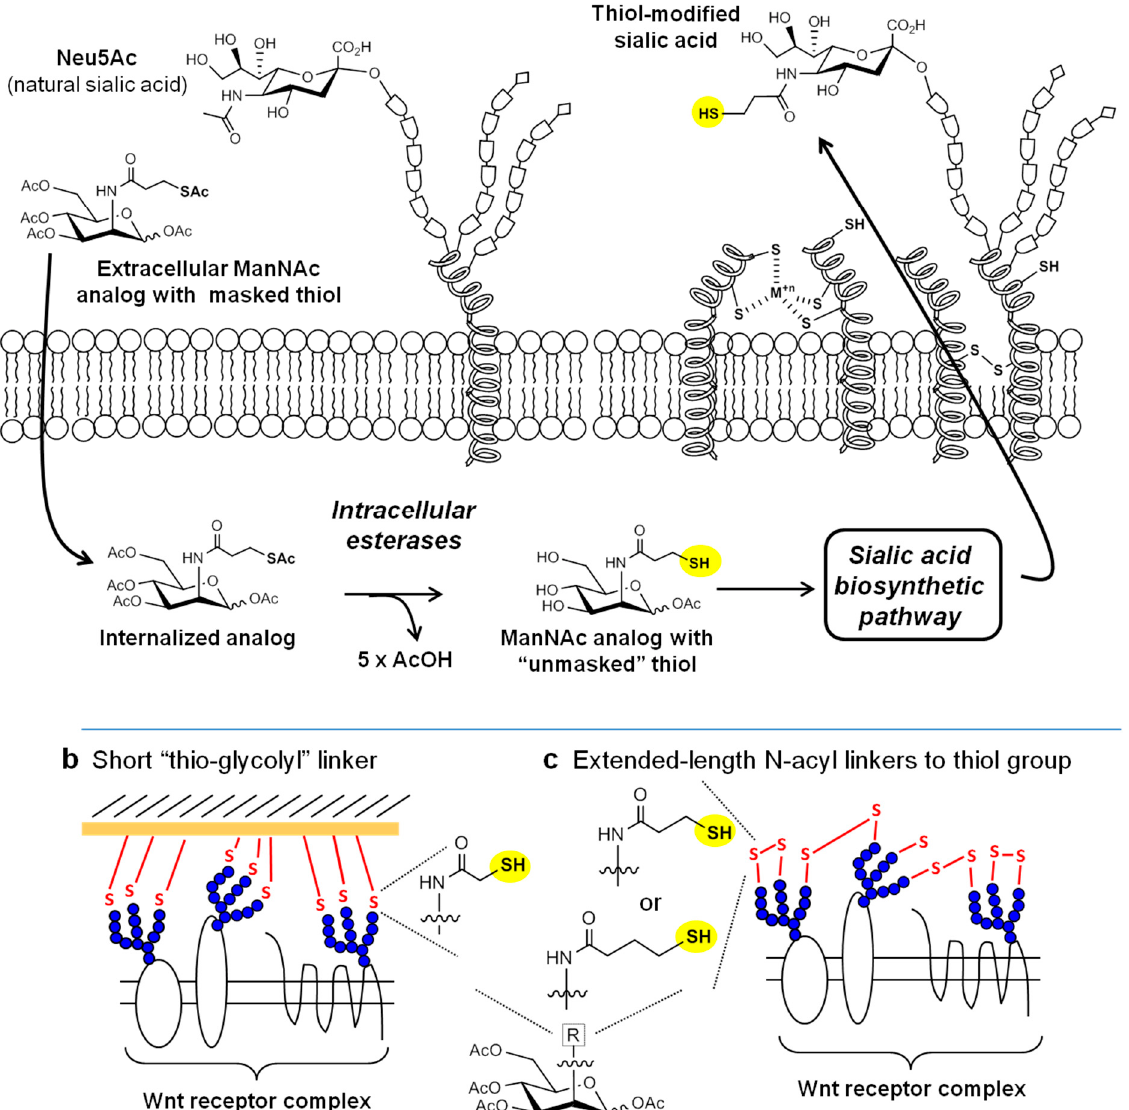
Figure 1. Overview of thiol-based metabolic glycoengineering (MGE). ( a ) Thiol groups can be metabolically installed into cell surface sialic acids by incubating cells with exogenously-supplied ManNAc analogs that have thiol groups masked by acetyl esters [5,8]; these protecting groups facilitate uptake into cells and then are removed (along with the analog’s hydroxyl esters [9,10]) by intracellular esterases [11,12]. The resulting thiol-modified ManNAc analogs intercept the sialic acid biosynthetic pathway and replace naturally-occurring sialic acids (e.g., Neu5Ac, the predominant form of this sugar in humans) in cell surface glycans with their thio-glycosialoside counterparts. ( b ) In previous work, we described the “scaffold-dependent” activity of thiol-modified sialic acids with short linker lengths between the thiol group and core sugar; an example of a ManNAc analog that installs such a sialic acid into cellular glycans is Ac 5 ManNTGc [5] (Figure 2). ( c ) In the current report, we describe thiol-modified analogs (e.g., Ac 5 ManNTProp and Ac 5 ManNTBut, also shown in Figure 2) with longer linkers (i.e., with 3 or 4 carbon atoms in the N -acyl linker) between the thiol and core sugar that have enhanced scaffold-independent biological responses.